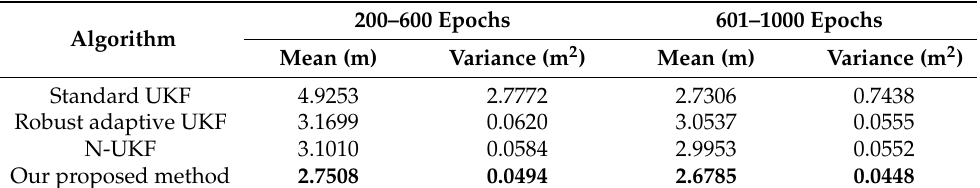
Table 2. Position tracking errors of the different algorithms for Case 2. The bold numbers stand for the minimum. Algorithm